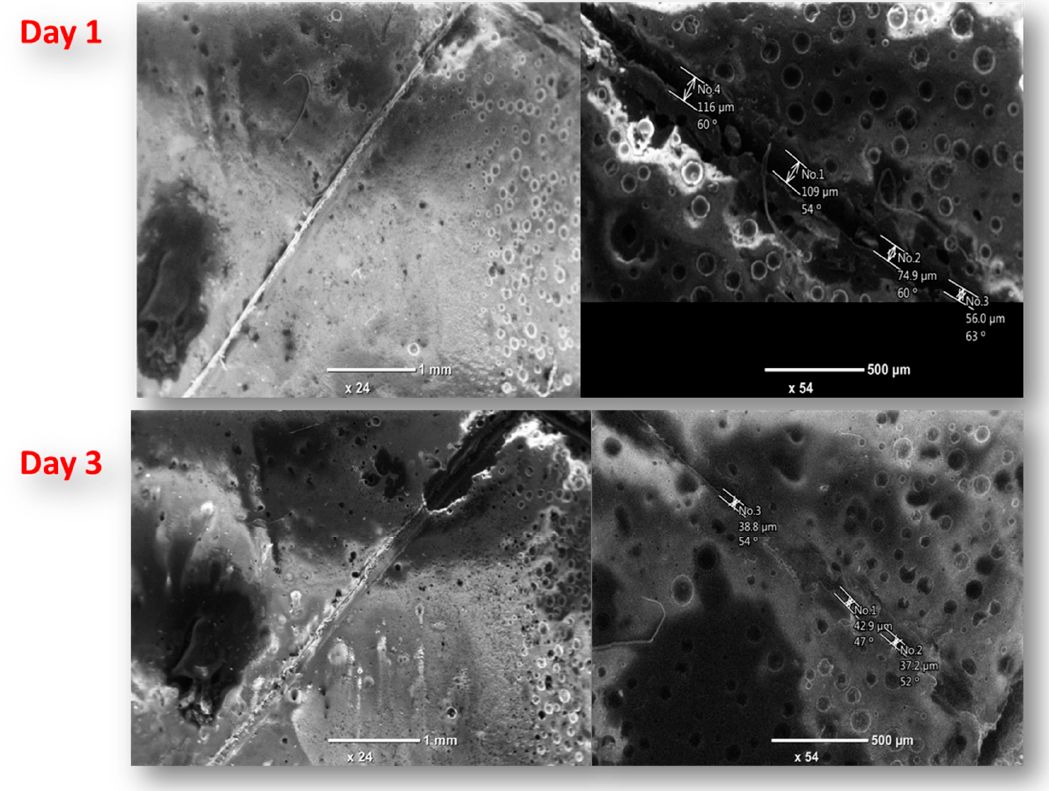
Figure 10. SEM images of the scratched samples after different time intervals.